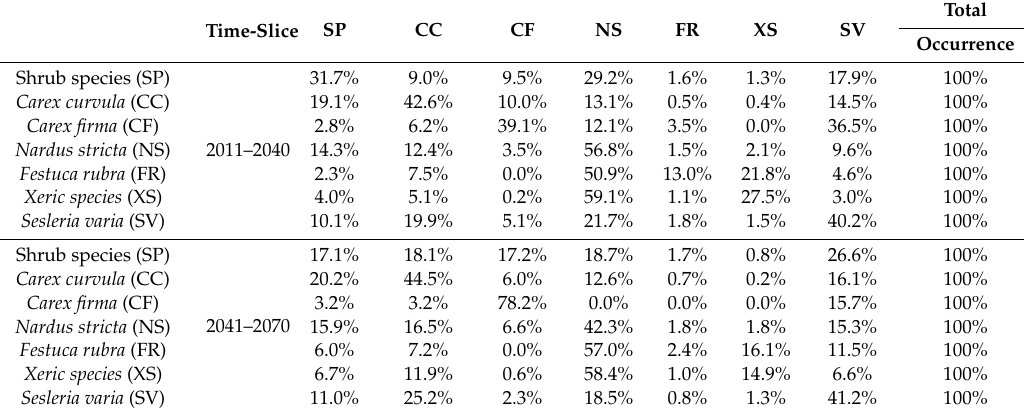
Table 6. Expected suitability change (in percentage) within each macro-type as reported by modeling ensemble for 2011–2040 and 2041–2070 averaged for both climate scenarios. The percentages correspond to the new suitable area for each macro-type within the total future extent of pastureland